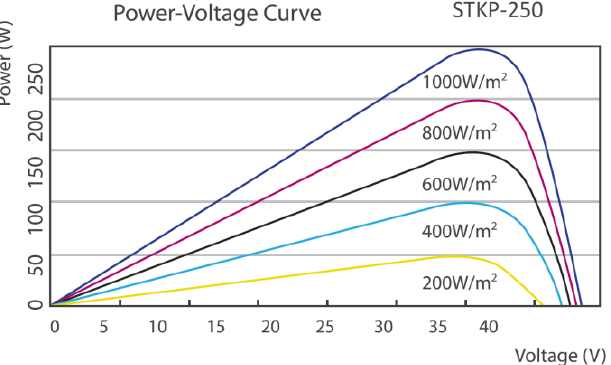
Figure 4. P-V curves of an SPV panel for different solar radiation conditions (adapted with permission from Ref. [107] Copyright 2022, Solar Electric London UK).